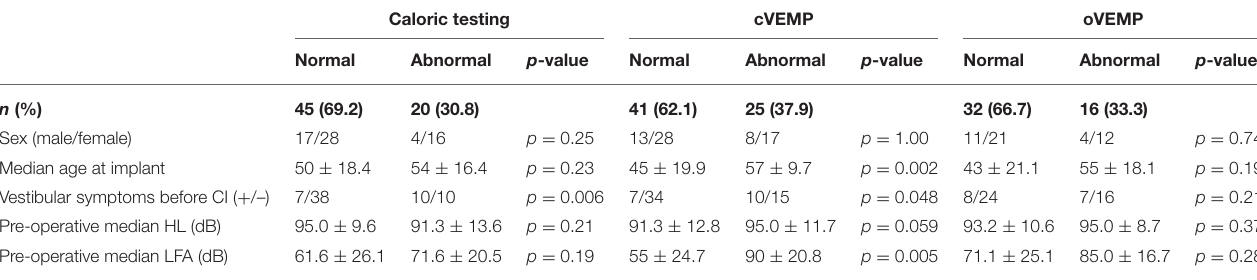
TABLE 1 | Summary of vestibular function before CI surgery.